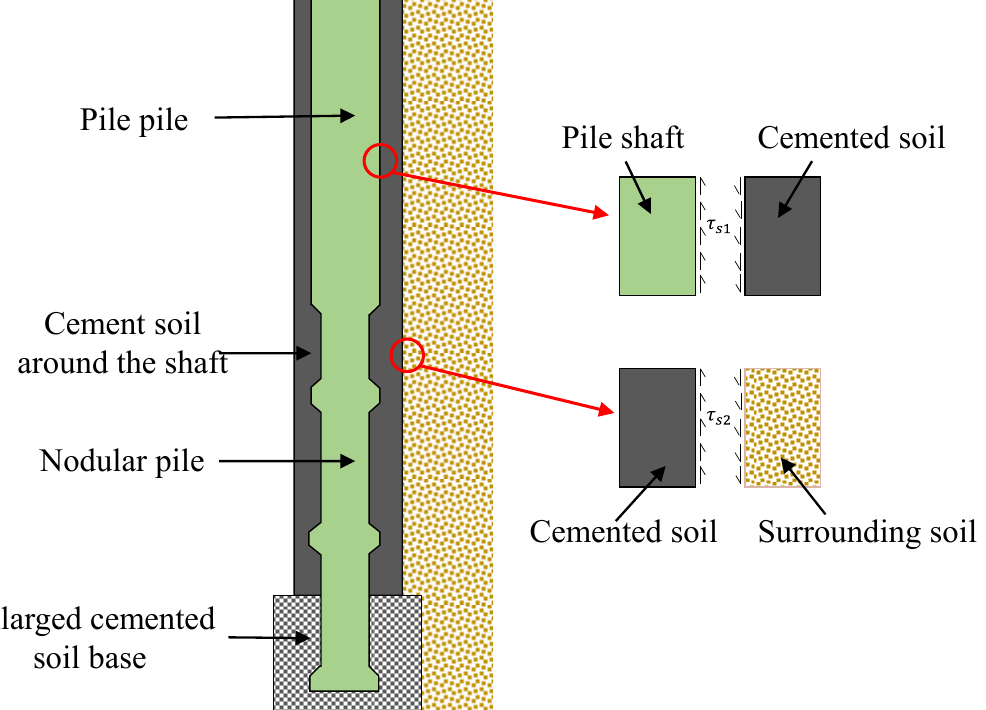
Figure 9. Schematic diagram of the PGPN pile [109].